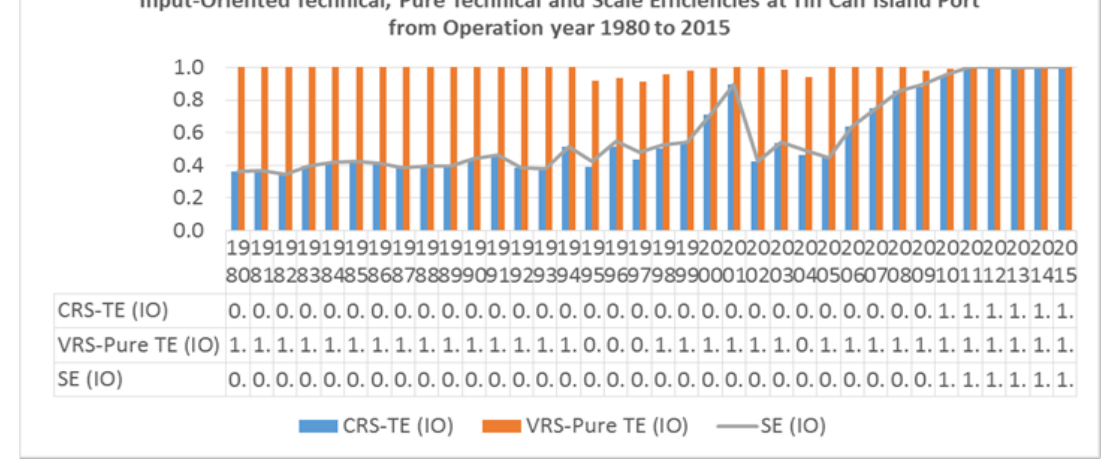
Figure 3: CRS – Technical Efficiency (Input-oriented) and CRS – Scale Efficiency